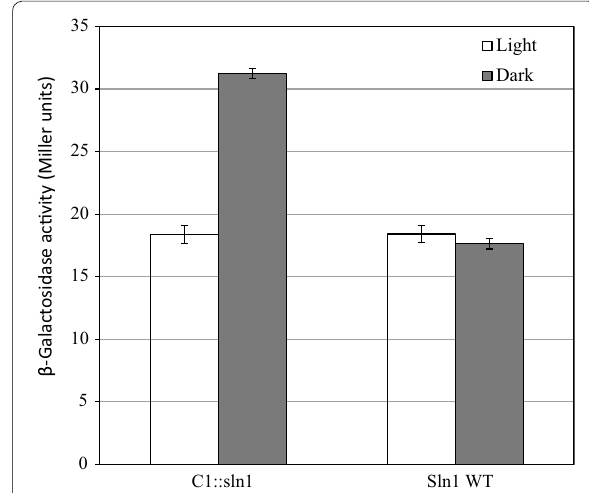
Fig. 3 Effect of illumination on the Skn7-dependent expression of the OCH1 - lacZ transcriptional fusion (i.e. the mannosyl-transferase gene fused with the reading frame encoding β-galactosidase) in a S. cerevisiae strain with the wild-type sln1 gene, and in a strain with sln1 replaced by the gene encoding the C1-histidine kinase fusion protein. Cells were incubated either in the presence of light (white bars) or in the dark (grey bars). The level of expression of the OCH1 - lacZ fusion is deduced from the specific β-galactosidase activity, expressed in Miller units. Error bars indicate standard deviations calculated from three independent biological